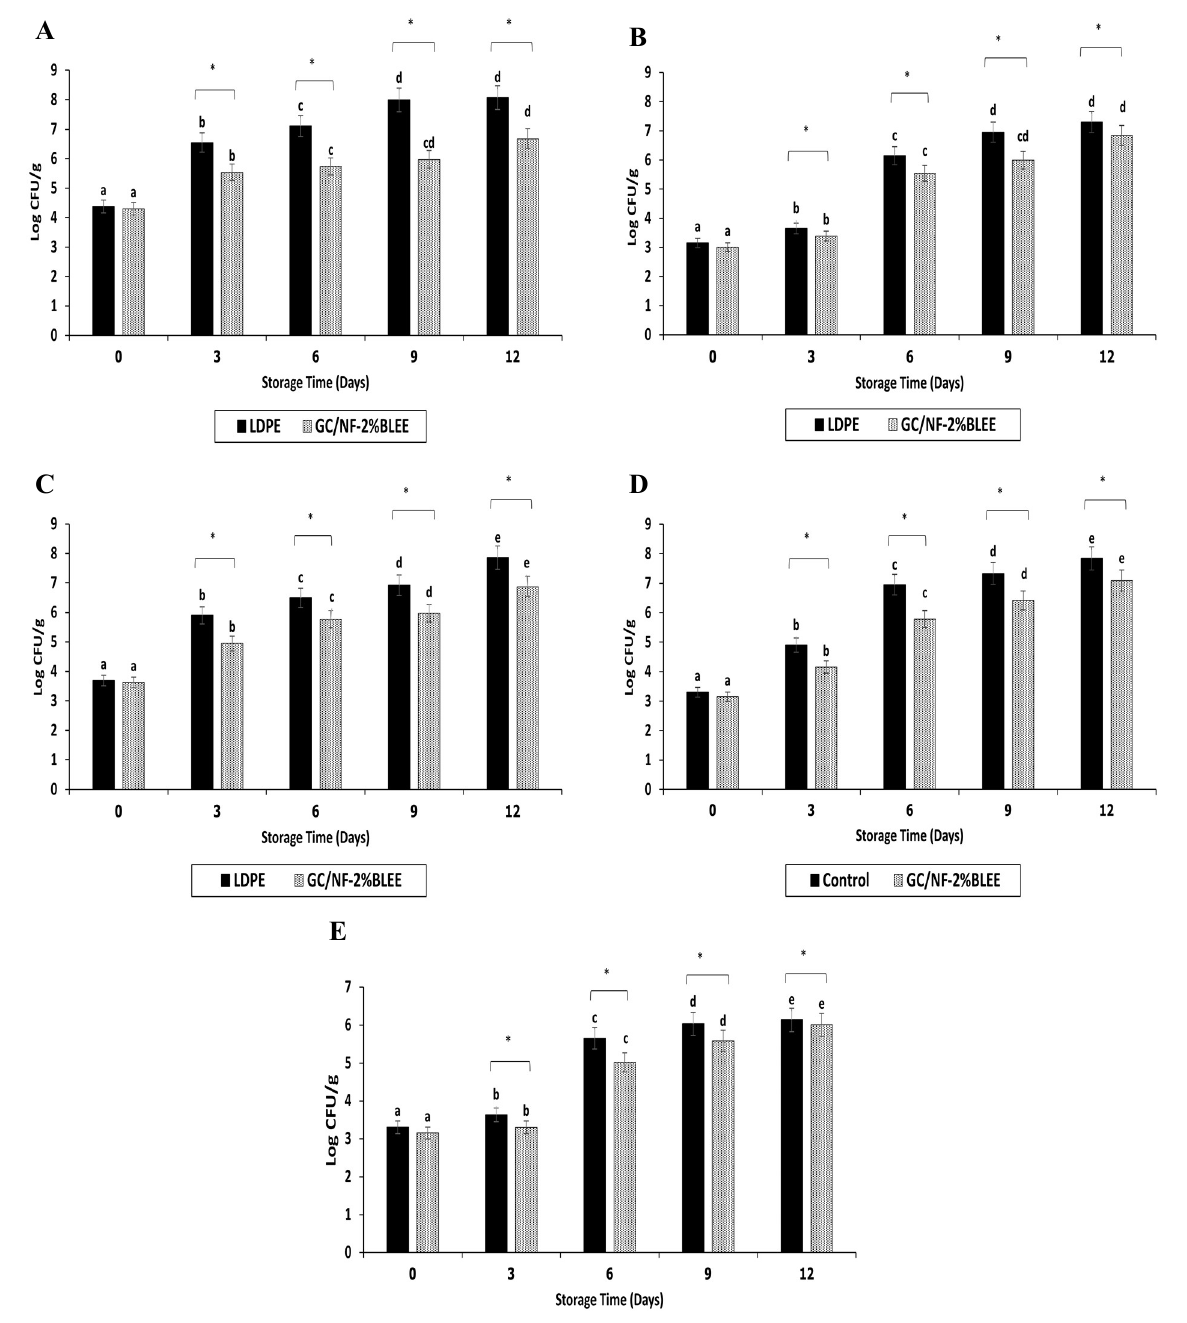
Figure 3. Total viable count ( A ), psychrophilic bacteria count ( B ), Pseudomonas sp. count ( C ), hydrogen sulfide-producing bacteria count ( D ), and Enterobacteriaceae sp. count ( E ) of tilapia slices packaged in different bags, during 12 days of refrigerated storage. Bars represent standard deviation (n = 3). Single asterisk (*) indicates significant difference ( p < 0.05). Different lowercase letters of samples packaged in the same bag indicate significant difference ( p < 0.05).